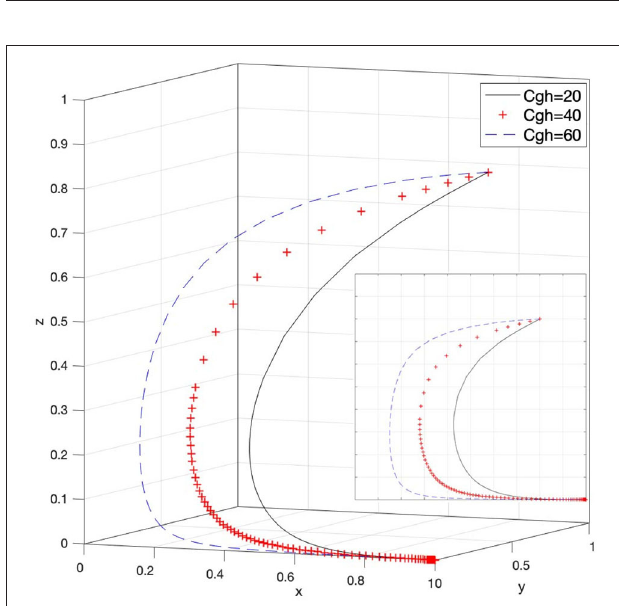
FIGURE 12 | Effect of the response cost on rights holders when rights holders actively protect their rights, and the government chooses strict supervision.